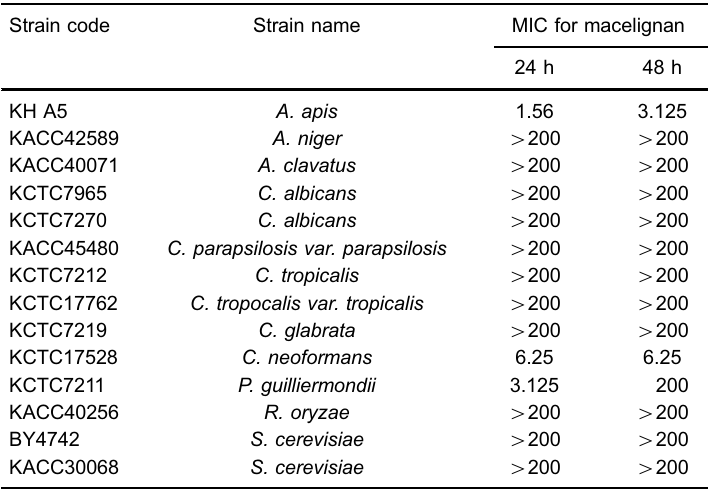
Table 2 . In vitro susceptibility of fungi to macelignan at 24 and 48 h. Strain